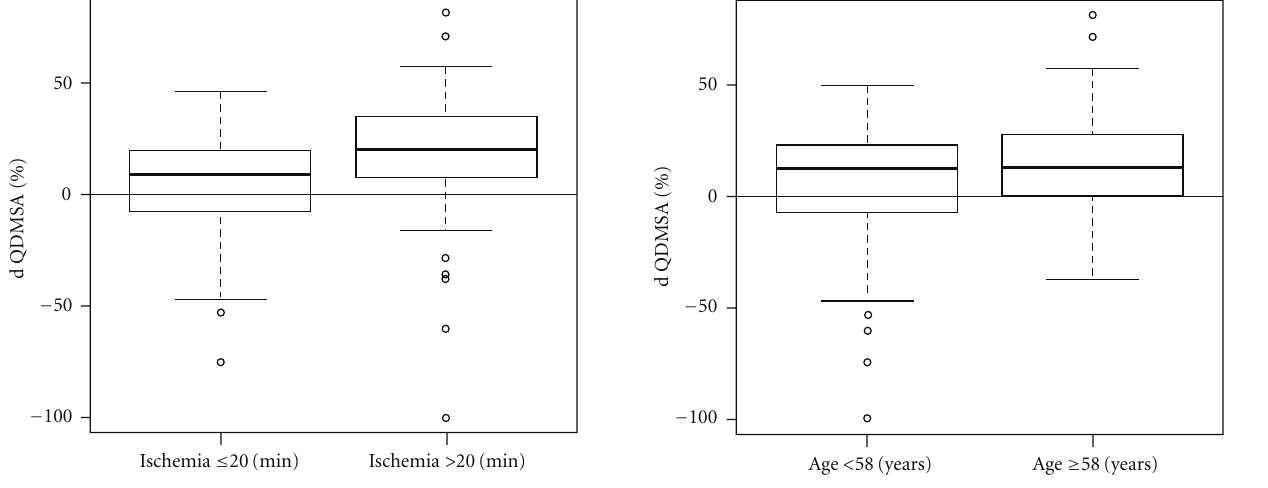
Figure 2: Mean change of postoperative renal function of the operated kidney as measured by QDMSA stratified according to duration of warm ischemia ( P = 0 . 008).